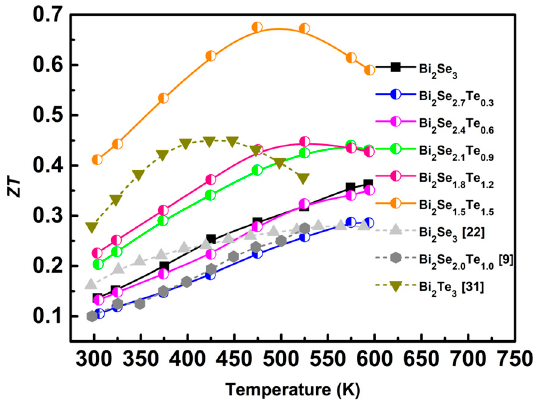
Figure 5. The temperature dependence of ZT for Bi 2 Se 3 − x Te x samples.